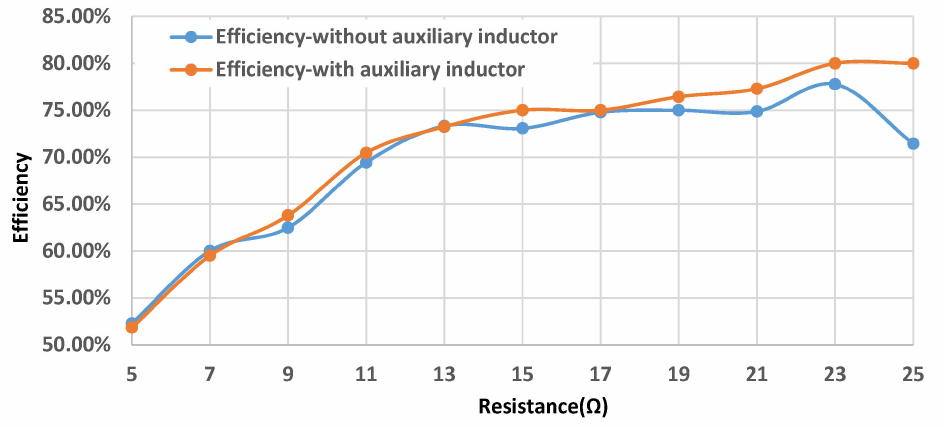
Figure 22. The comparison of the inverter efficiency by adding the auxiliary inductor and without using the auxiliary